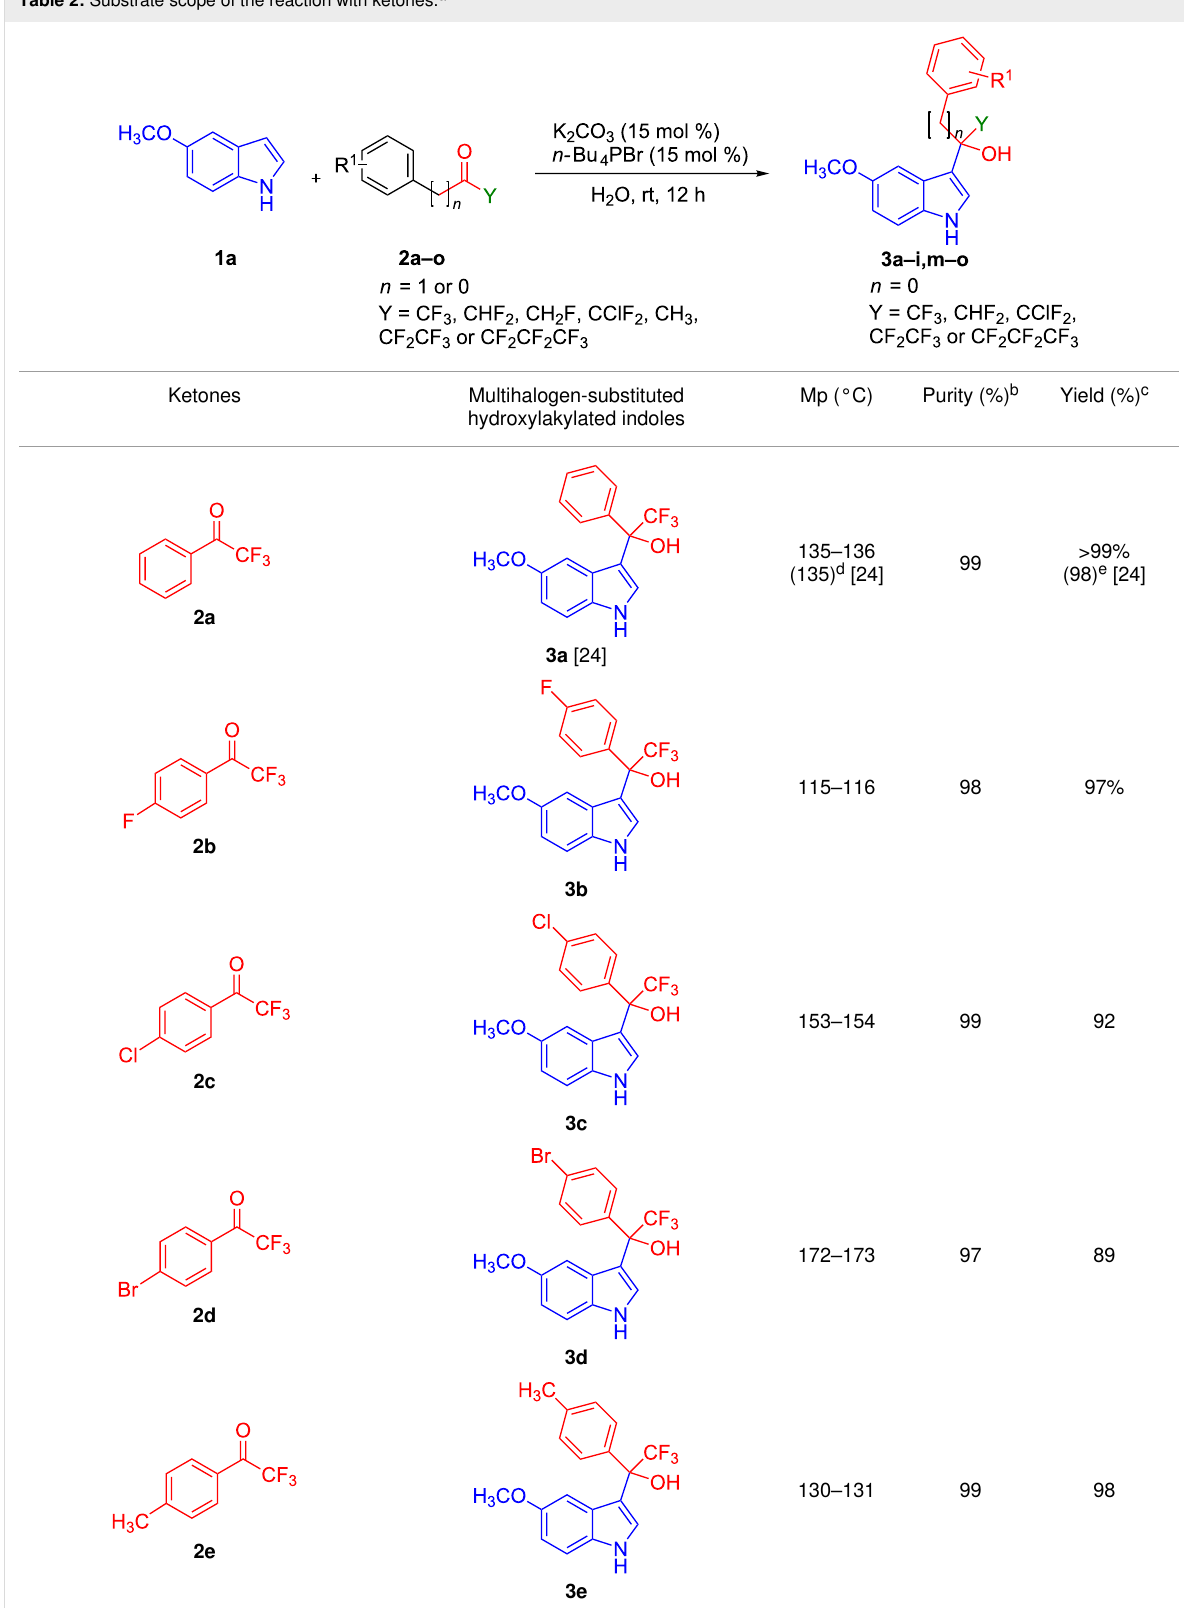
Table 2: Substrate scope of the reaction with ketones.